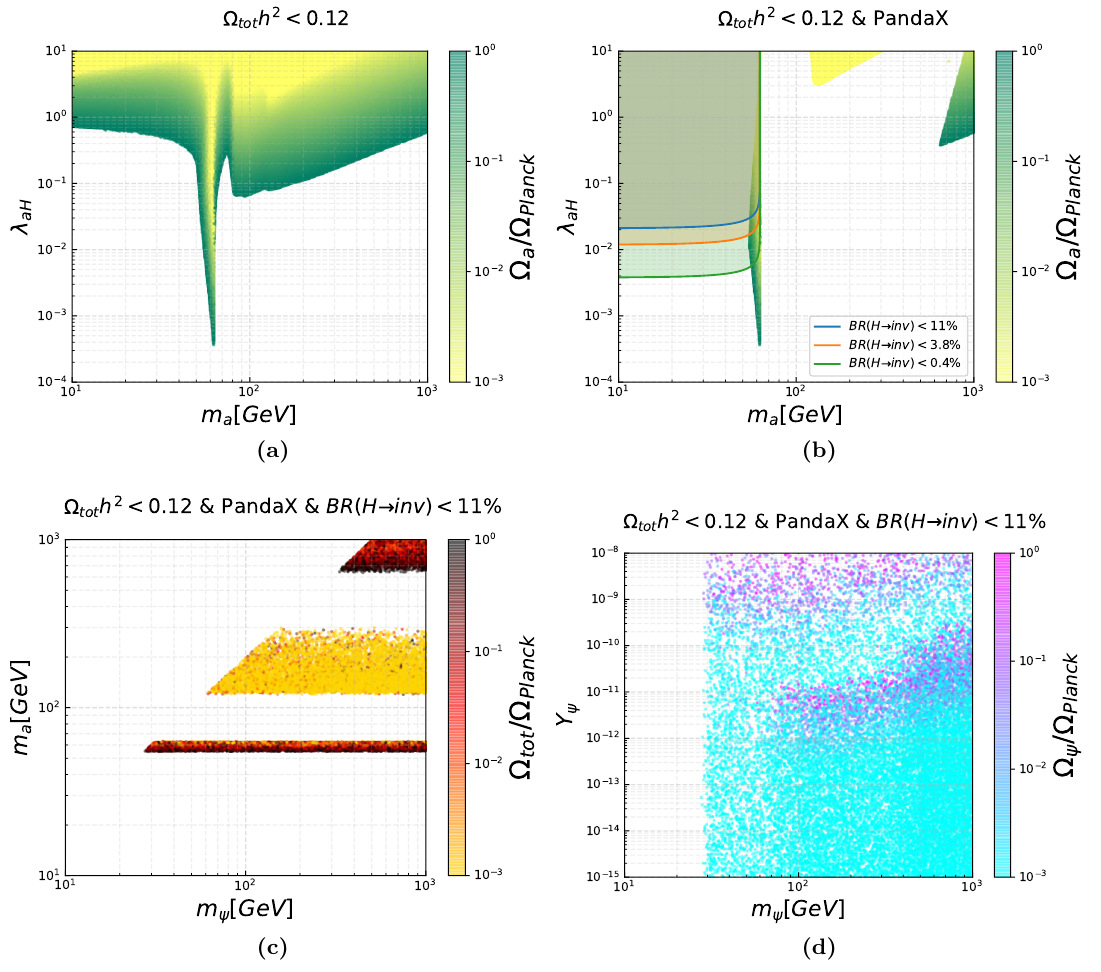
˜ (CP-odd) model with F 0 S 0 0 0 Ω ), ψ a / Planck